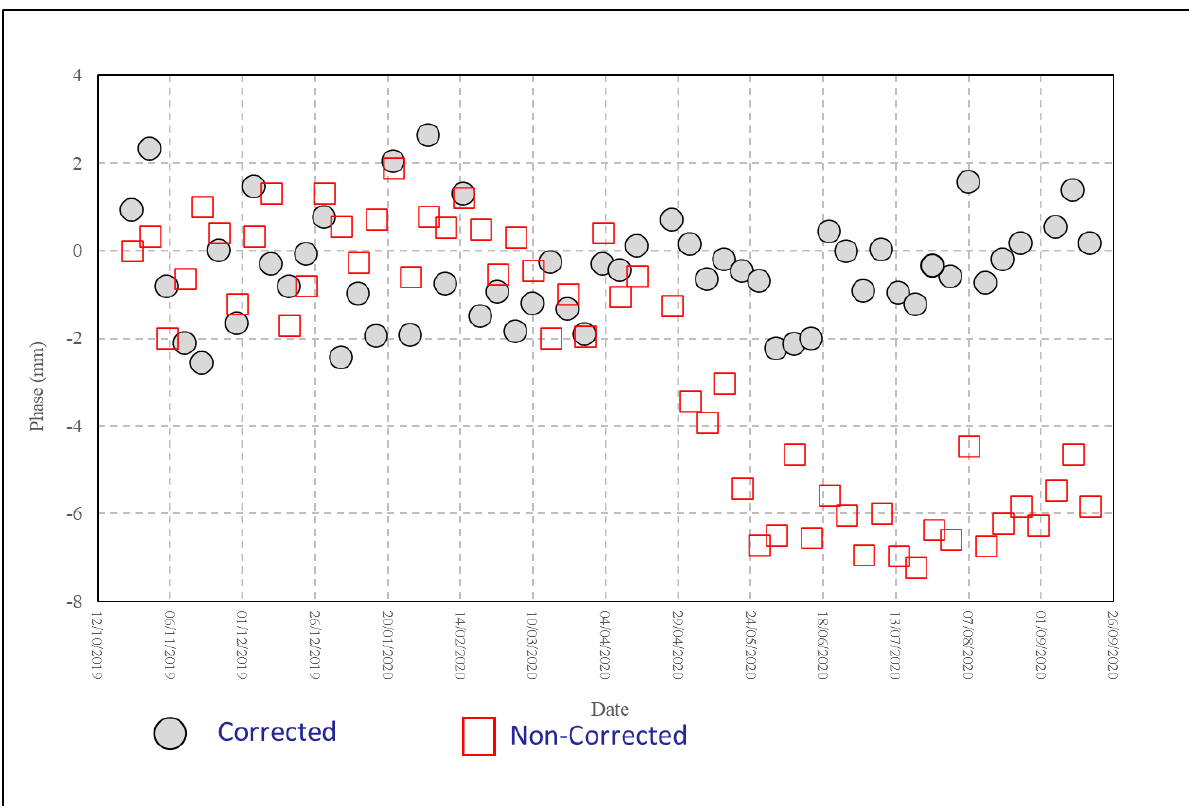
Figure 10. Cumulated deformation shown in Figure 6 (red squares) and corrected version using the equation shown in Figure 9 (circles). Modified from Luzi et al.